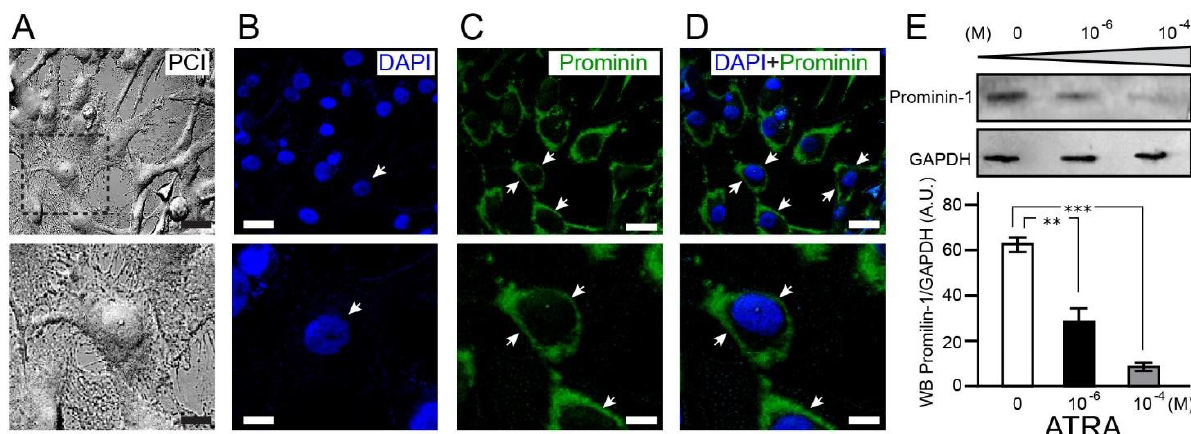
Figure 1. The widely expressed stem cell marker prominin-1 in U87MG is curtailed in a dose dependent manner by ATRA. Phase contrast image (PCI) of early passaged U87MG grown to 8090% confluency (( A ), upper). Boxed region shown in higher magnification (( A ), lower) showing a representative U87MG cell with large nucleus and cytoplasmic projections. Confocal micrographs with U87MG nuclear staining (arrow; DAPI — Blue; ( B )), stem cell marker prominin-1 revealing strong cytoplasmic expression pattern (arrow; Alexa fluor 488; Green; ( C )) without ATRA treatment. Merged images ( D ) showing lack of prominin-1 peri-nuclear expression. Scale bars: 20 µm (upper) and 10 µm (lower). Representative Western blot highlighting decreased prominin-1 expression in U87MG with increasing ATRA exposure and GAPDH as a loading control (( E ), upper). Histograms depicting Western blot analysis and significant inverse relationship between prominin-1 expression and ATRA exposure (( E ), lower). Asterisks represents p < 0.05 significance, n = 2.